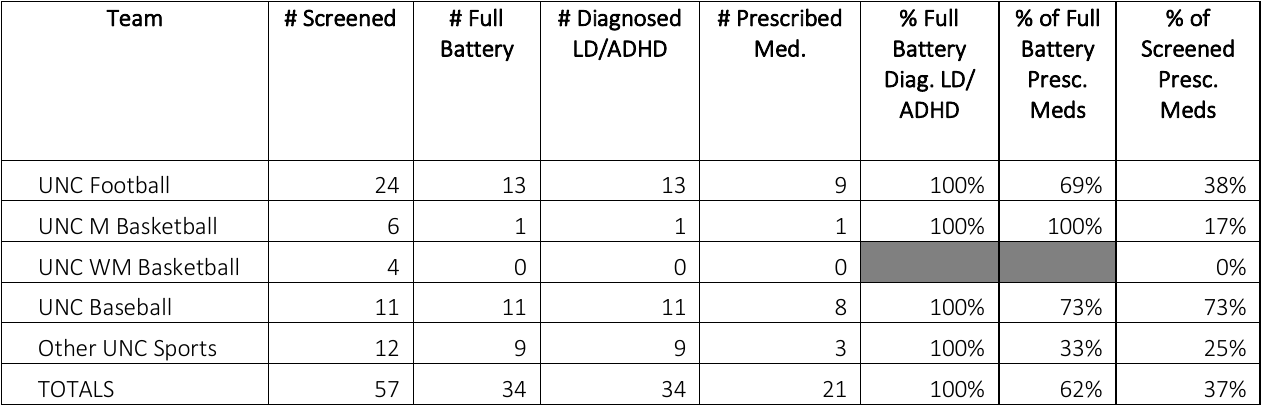
Table 1: UNC Academic Screens, LD/ADHD Testing 2011-2012 – Replication of UNC Learning Specialist’s 2011-2012 End-of- Year Report ( correcting error in totals*